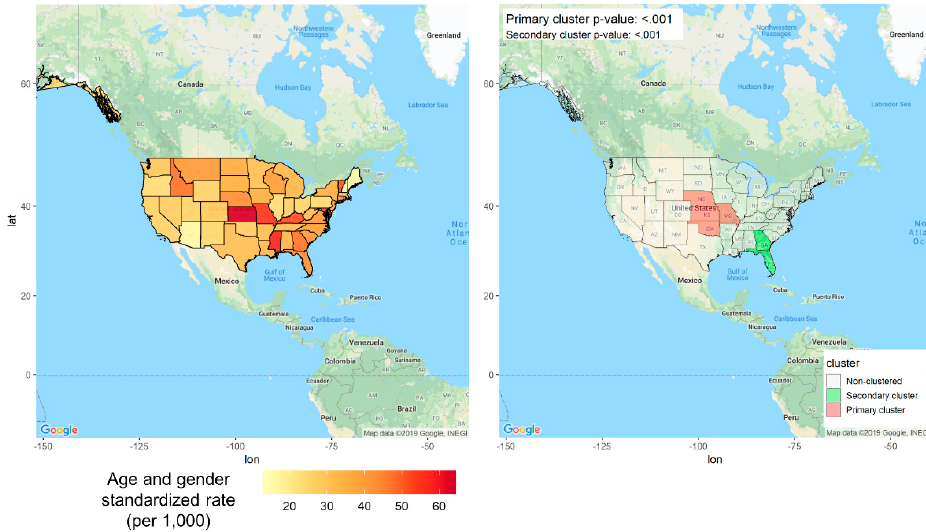
Figure 5. Disease mapping and clustering for regional differences in the incidence of all heart diseases in the United States from 2008 to 2010 (age and gender adjusted).